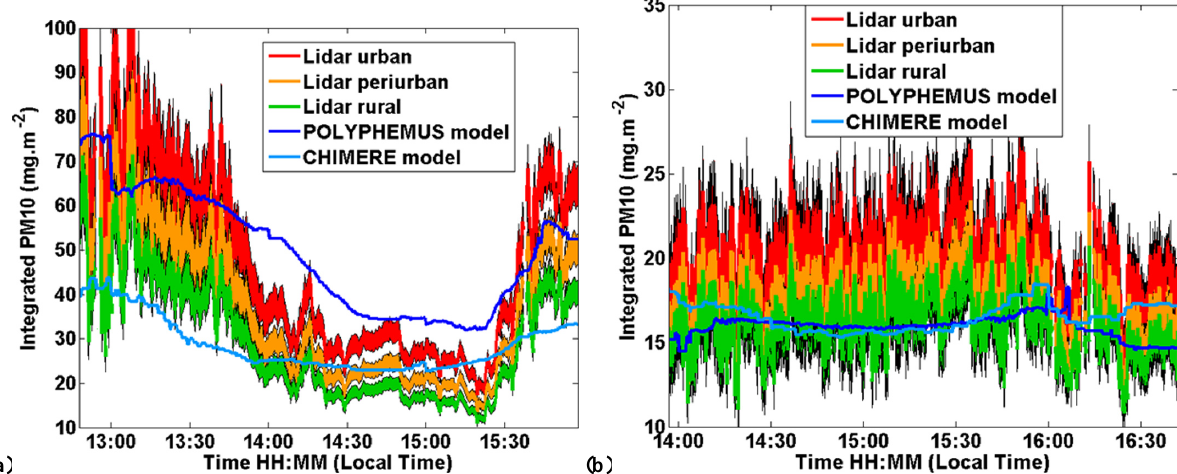
Fig. 7. Comparison for 1 (a) and 15 July 2009 (b) of wet integrated PM 10 (between the ground and 1km a.g.l.) derived from GBML using urban (red curves), peri-urban (orange) and rural relationships (green), and modeled with POLYPHEMUS plateform (in dark blue) and CHIMERE model (in light blue). The shaded areas on lidar integrated PM 10 represent the uncertainty on hygroscopic